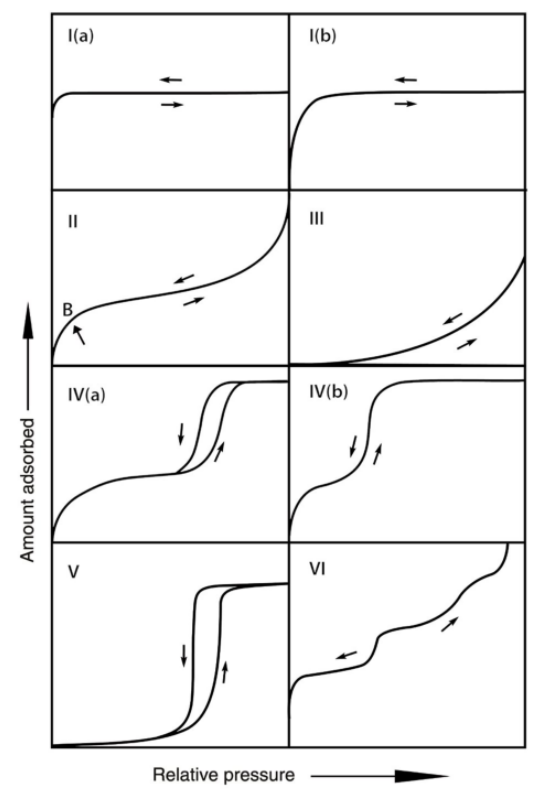
Figure 3. Classification of physisorption isotherms [36]. Note: the quantity of gas adsorbed may be measured in any convenient units: moles, grams, and cubic centimeters et al were all used.